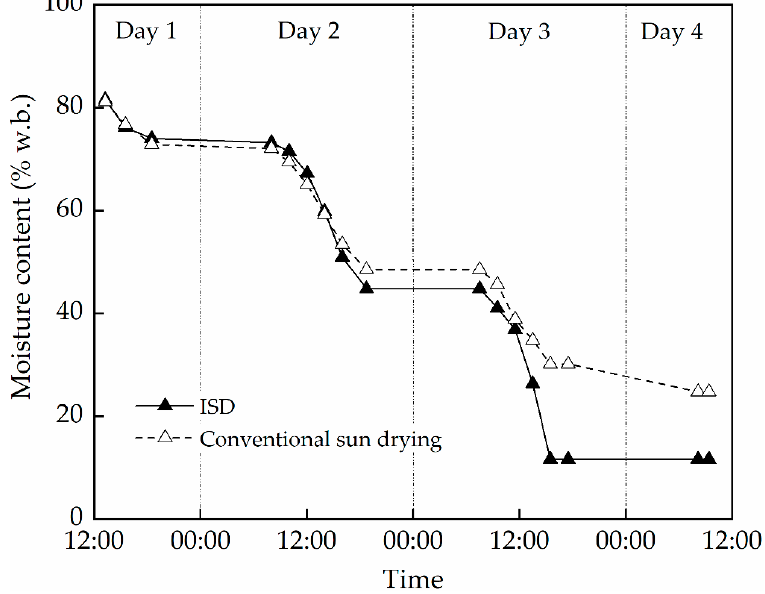
Figure 7. Moisture content (MC) over time of amaranth leaves dried in the ISD and under sun drying (8–11 December 2016).